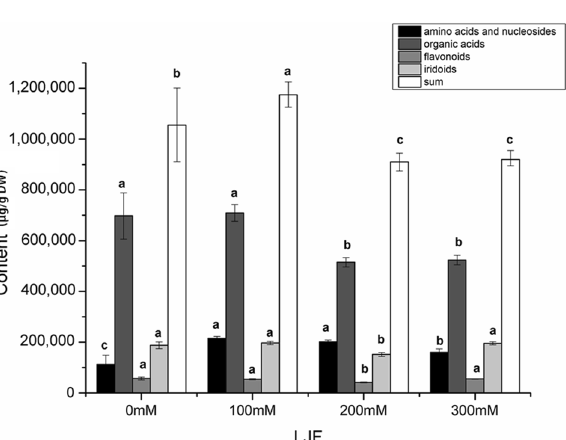
Table 2. Regression equations, limit of detection (LOD), limit of quantification (LOQ), precisions, repeatabilities, stabilities, and recoveries for 47 bioactive components of Lonicerae Japonicae Flos.